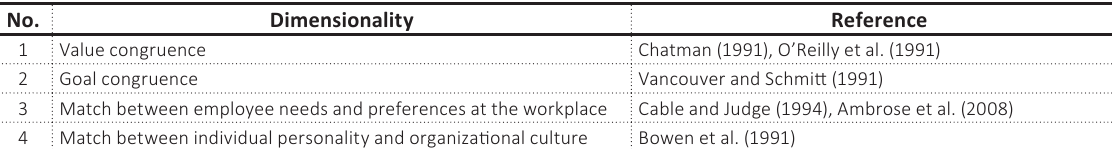
Table 2. Dimensionality of P-O